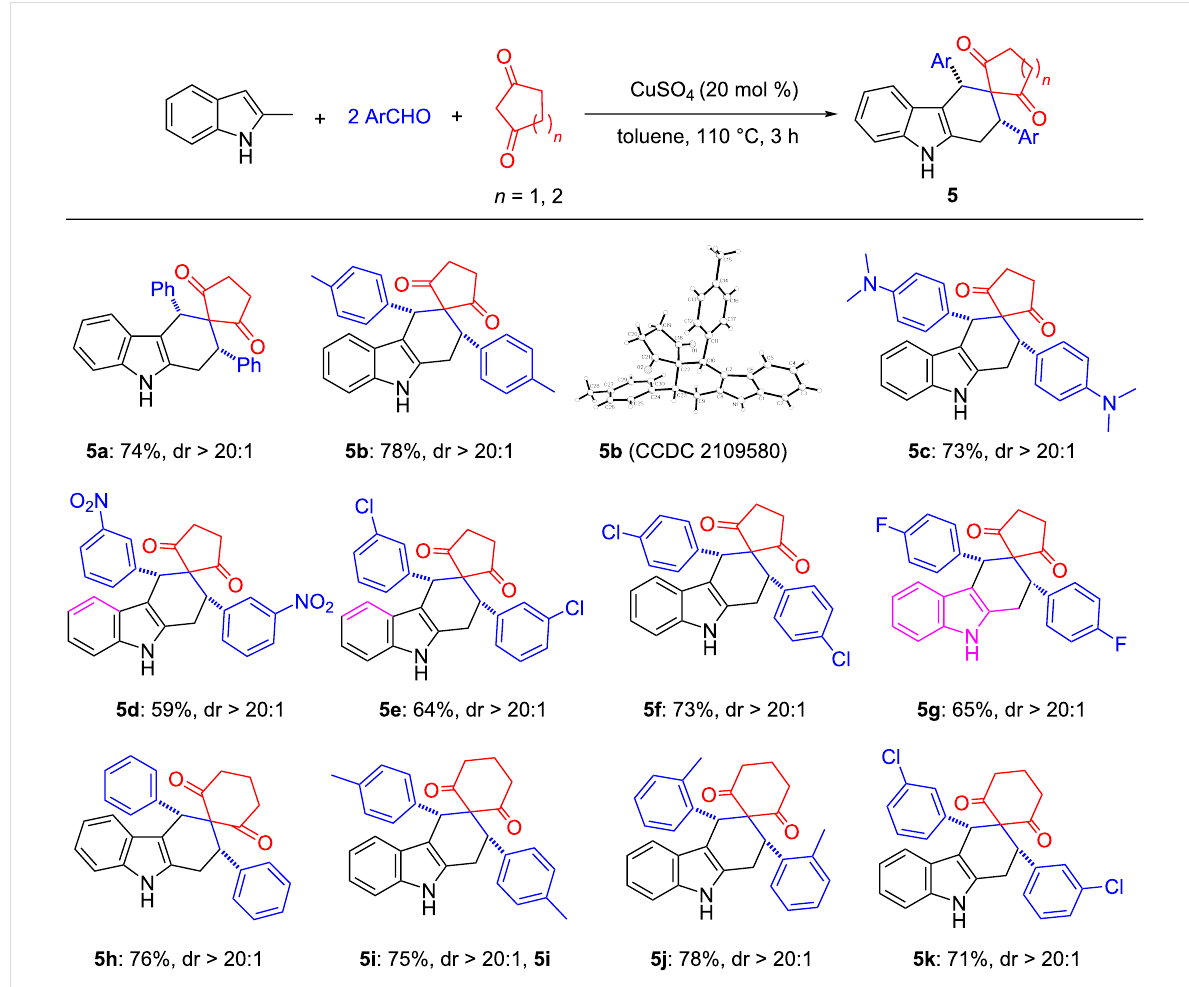
Scheme 5: Synthesis of tetrahydrospiro[carbazole-3,1'-cycloalkane]-diones. Reaction conditions: 2-methylindole (0.5 mmol), aromatic aldehyde (1.0 mmol), cyclic 1,3-dione (0.5 mmol), CuSO 4 (0.1 mmol), toluene (6.0 mL), 110 °C, 3 h. Isolated yields are shown. The dr values were determined by 1 H